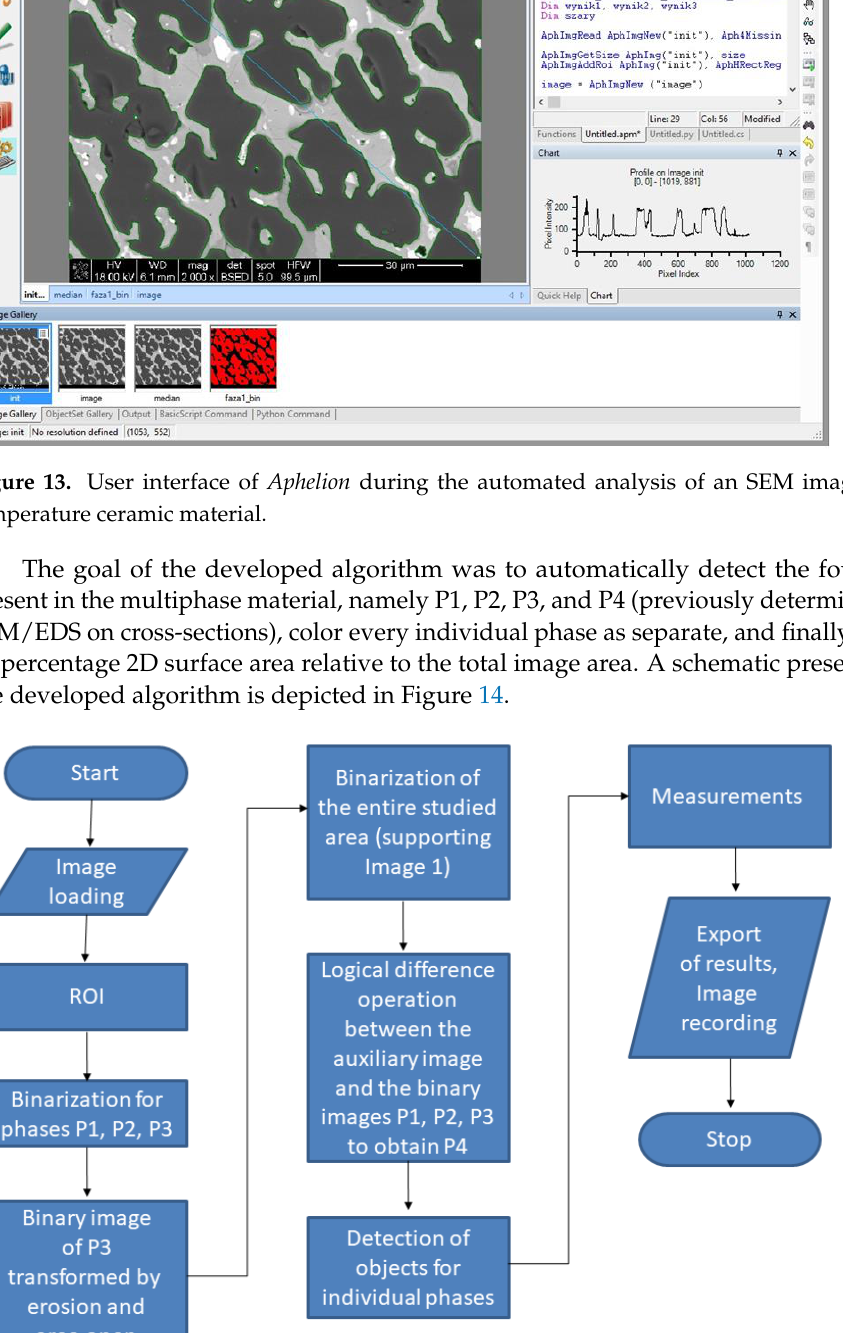
Figure 14. Flowchart summarizing the developed algorithm for image analysis.